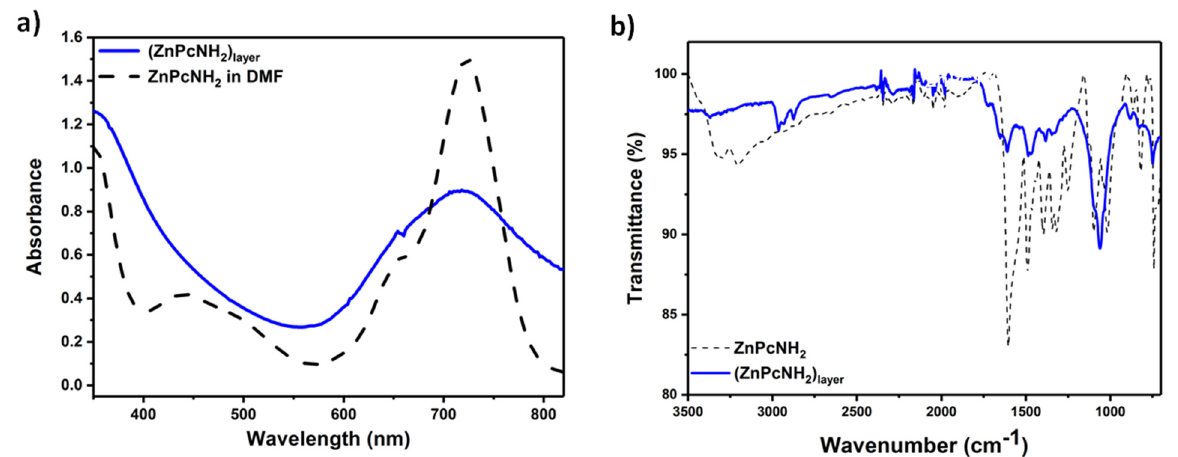
Figure 3. ( a ) UV–Vis of ZnPcNH 2 (black dashed line) and (ZnPcNH 2 ) layer (blue line); ( b ) ATR-IR spectra of ZnPcNH 2 (black dashed line) and (ZnPcNH 2 ) layer (blue line).